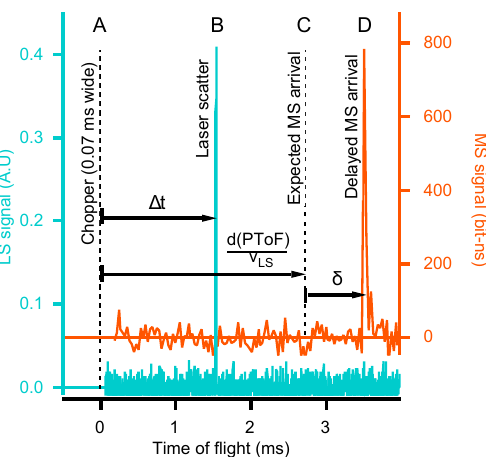
Figure 3. Illustration of LS and MS signals for a typical delayed single particle in AMS. Scattered light signal (teal) and mass spec- trometer signal (orange) as a function of particle time of flight for an example delayed particle. The particle velocity ( v LS ) is calculated by the measured time between the start of the chopper cycle (point A) and detection of the scattered light peak (B). The velocity is used to estimate an expected arrival time of the chemical ion signal at the mass spectrometer (C) assuming prompt evaporation and ionization of the particle at the vaporizer. The difference between the expected (C) and actual (D) arrival times is denoted by δ and allows for the operational definition of prompt and delayed particle events.